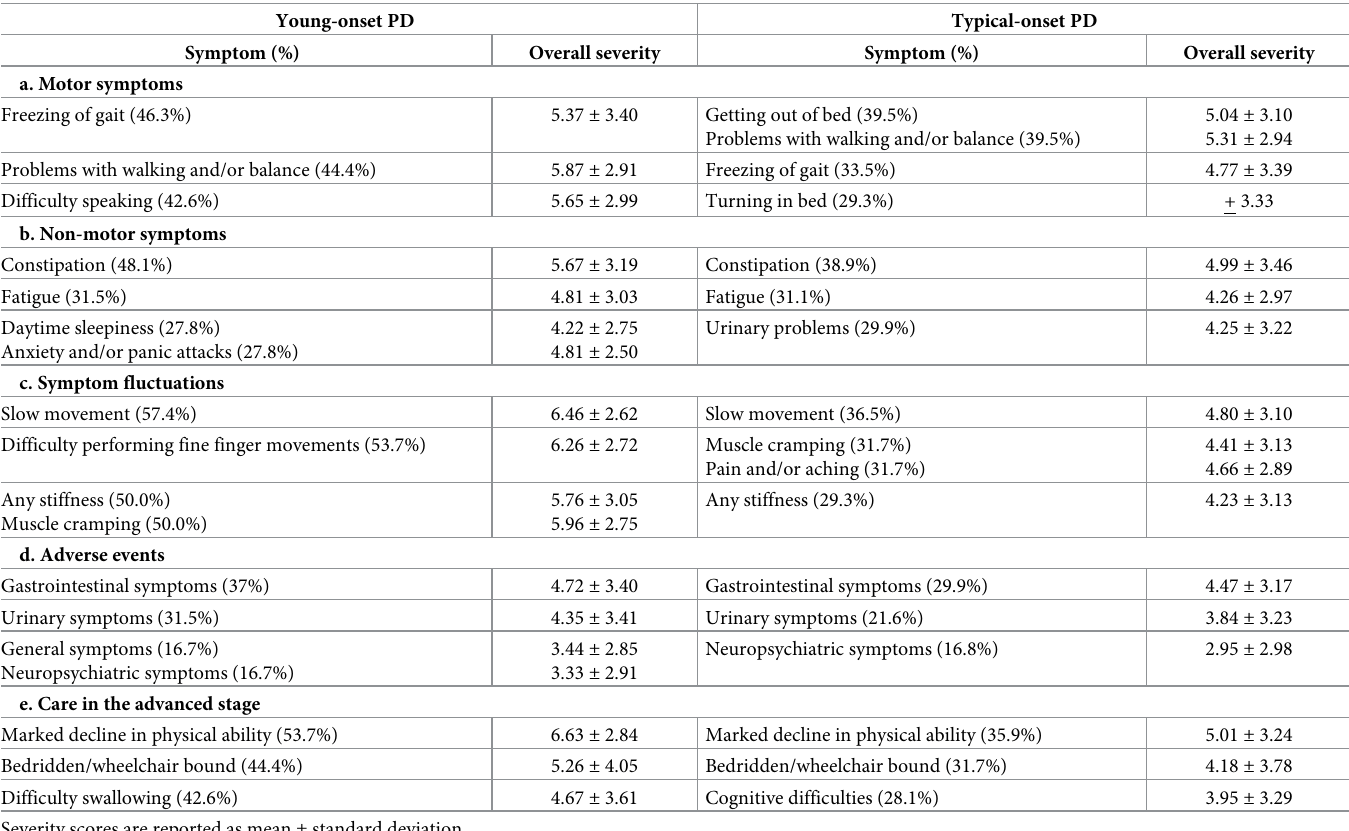
Table 5. Comparison of the most commonly concerning symptoms between young-onset and typical-onset PD patients on (a) motor symptoms, (b) non-motor symptoms, (c) symptom fluctuations, (d) adverse events, and (e) care in the advanced stage (n =